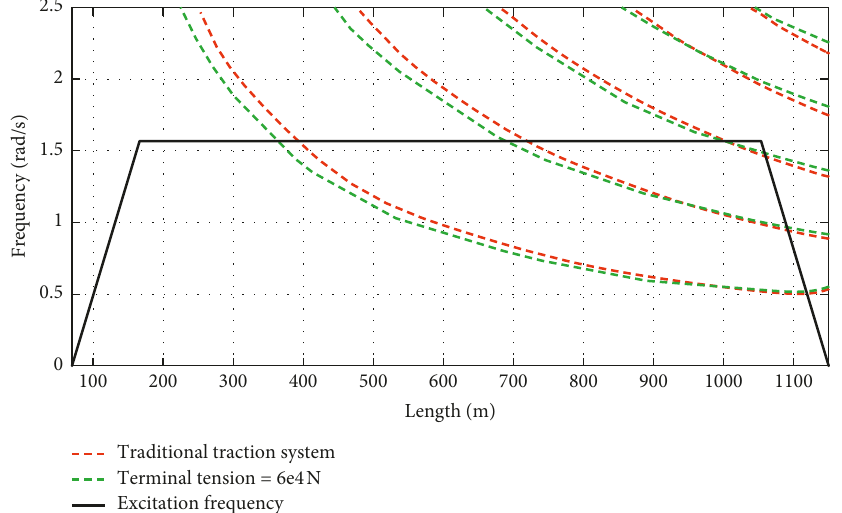
Figure 18: Comparison of natural frequencies of transverse